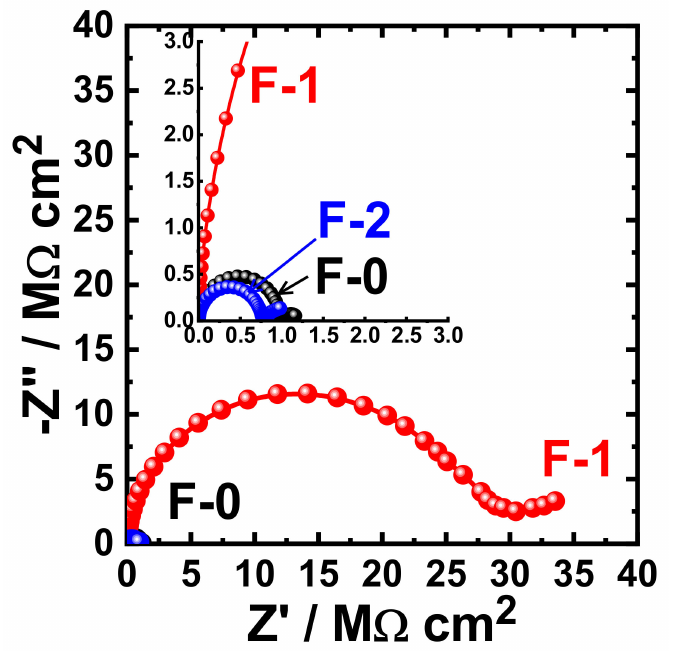
Figure 18. Typical Nyquist plots obtained for F-0, F-1, and F-2 after their immersion in 3.5% NaCl solutions for 21 days.